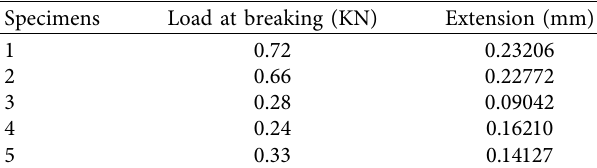
Table 2: Breaking load and extension of specimens.